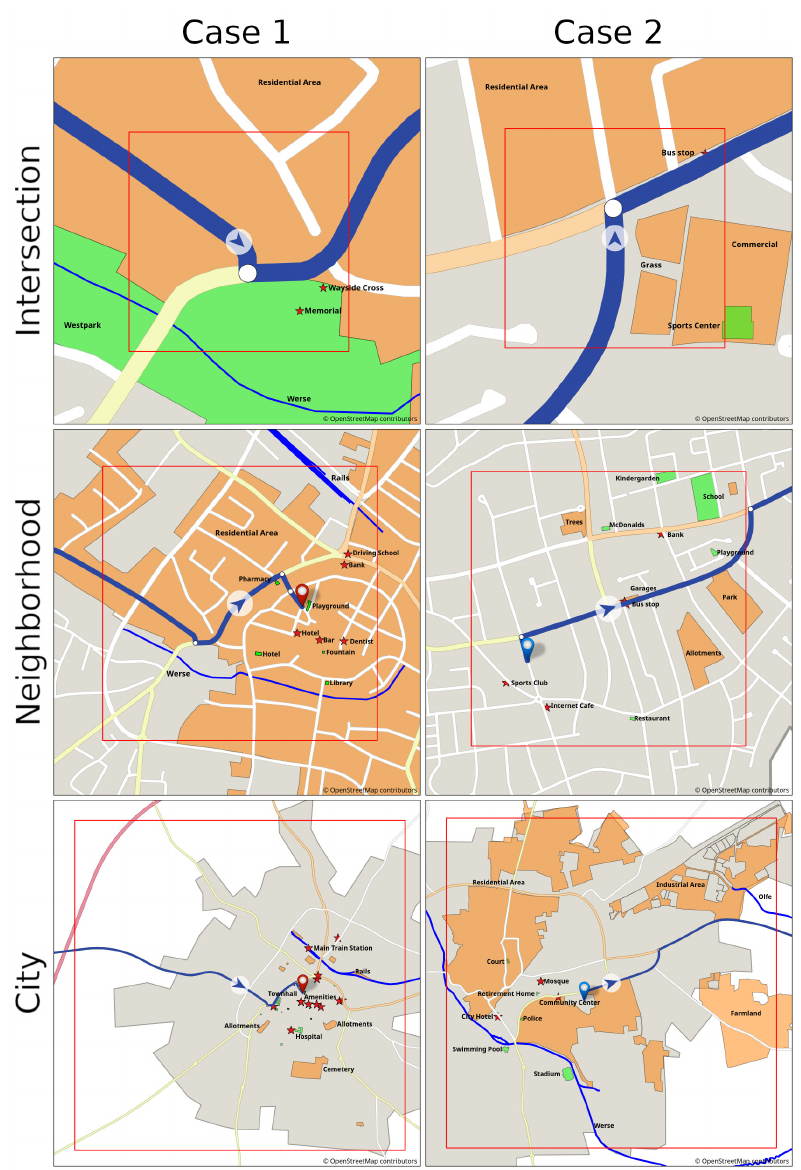
Figure 3: Results for the three prototypical contexts and two use cases. Features are highlighted as follows: administrative regions–gray, environmental regions–orange, point landmarks–red, linear landmarks–blue, areal